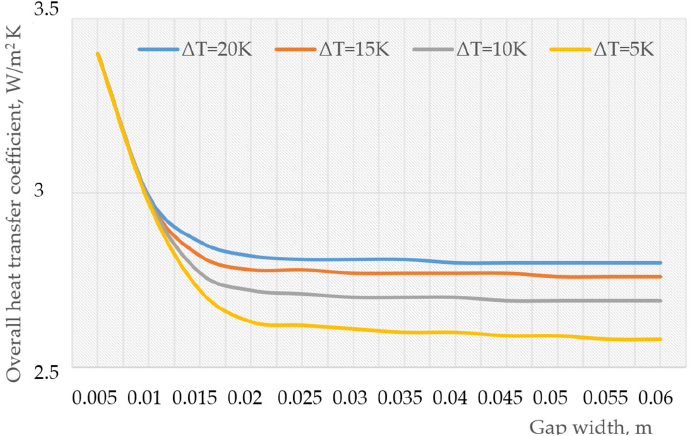
Figure 5. Variation of the overall heat transfer coefficient depending on the width of the gap between panes for four internal surface temperature differences (summarized data from cited papers).